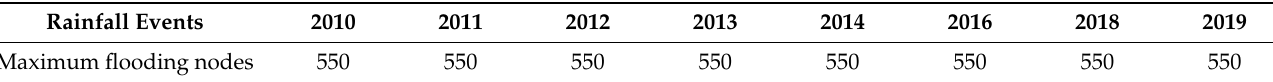
Table 2. Results of maximum fl ooding nodes.